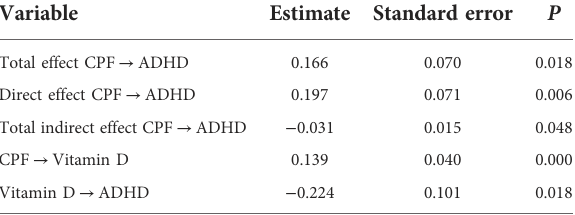
TABLE 2 Standardized effect size of associated factors of ADHD analyzed using path